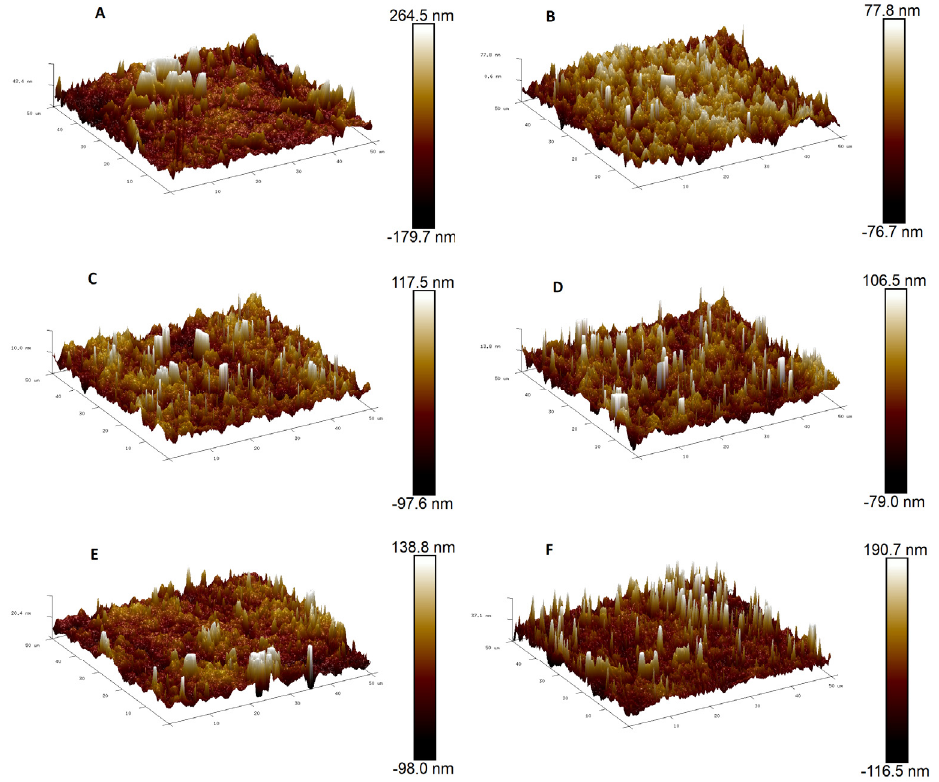
Figure 3. 50 µm × 50 µm atomic force microscopy images for ( A ) control PPSU membrane, ( B ) 0.1 wt%, ( C ) 0.3 wt%, ( D ) 0.6 wt%, ( E ) 1 wt% and ( F ) 1.5 wt% MXene-modi fi ed NF membranes. ( C ) 0.3 wt.%, ( D ) 0.6 wt.%, ( E ) 1 wt.% and ( F ) 1.5 wt.% MXene-modified NF